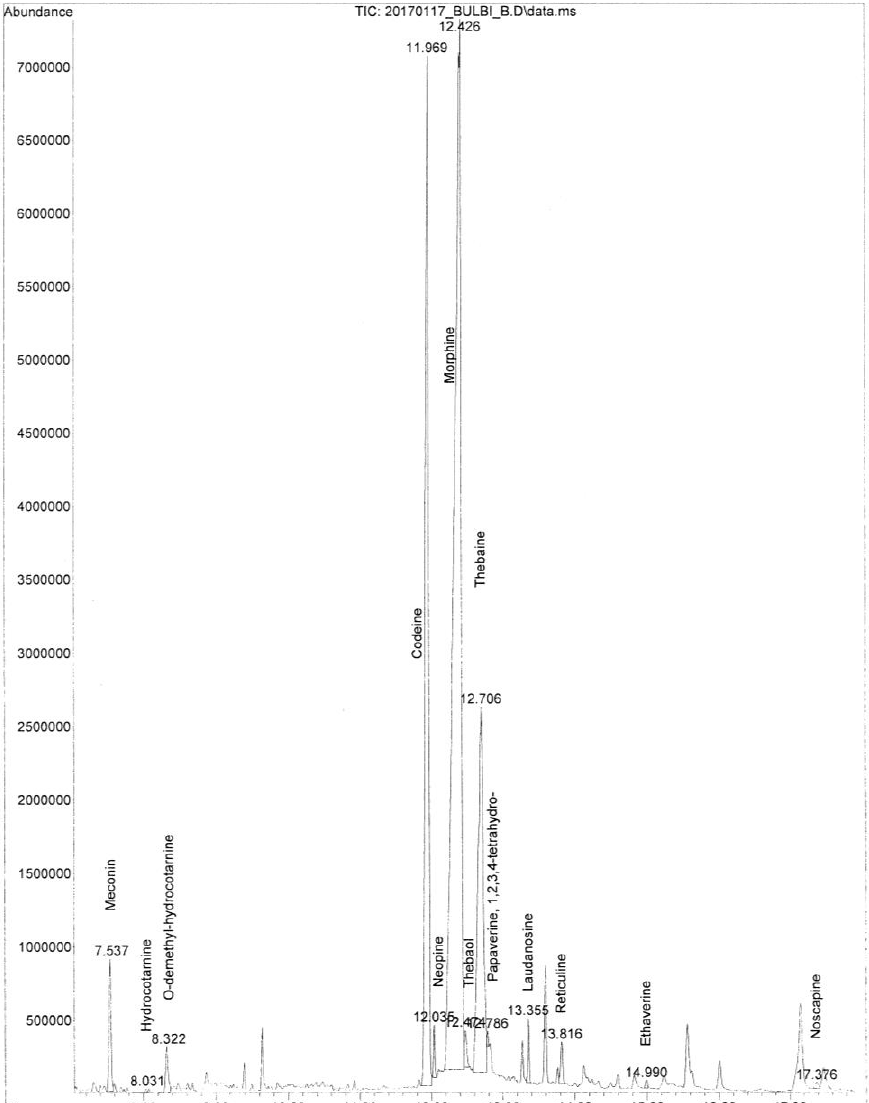
Figure 3. GC/MS total ion chromatogram of the alkaloids detected in the samples, including the ethaverine used as an internal standard.